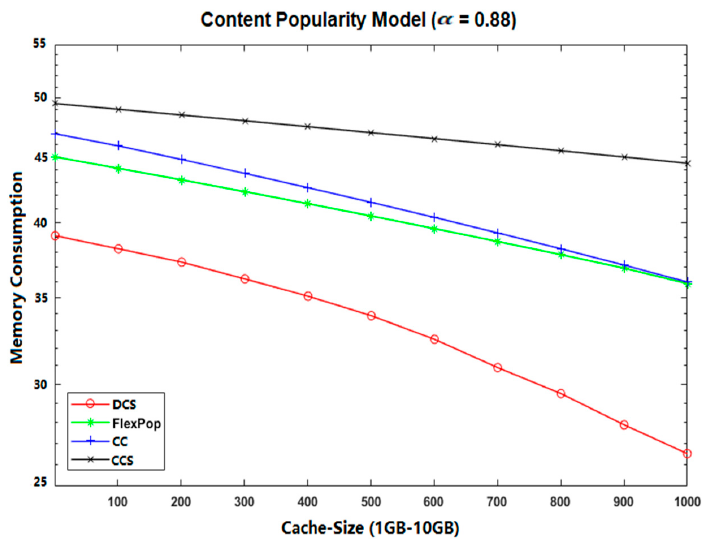
Figure 7. Memory Consumption on Abilene topology with UGC.